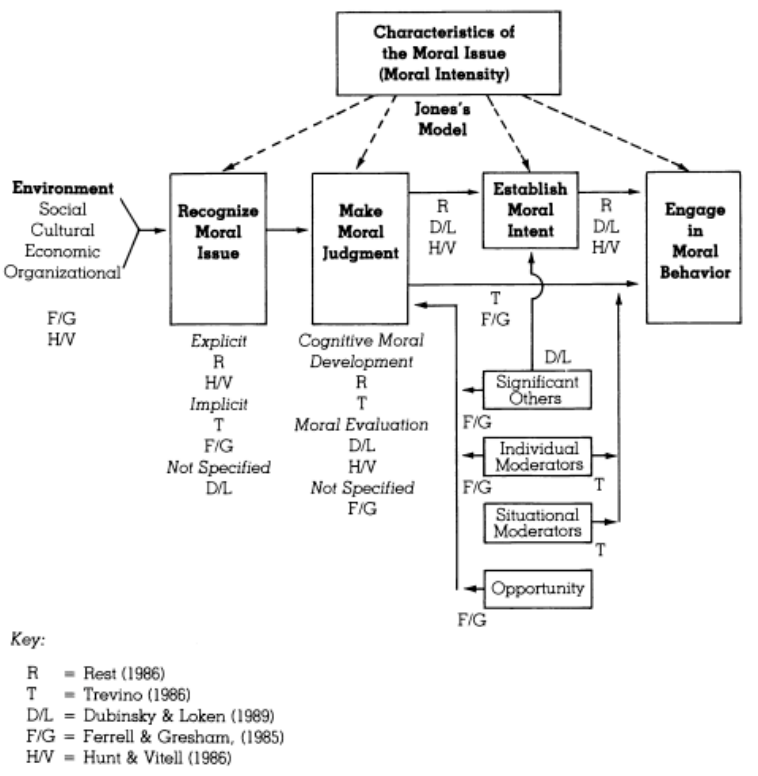
Figure 2. Jones’ Synthesis of Ethical Decision-Making Models (Torres,